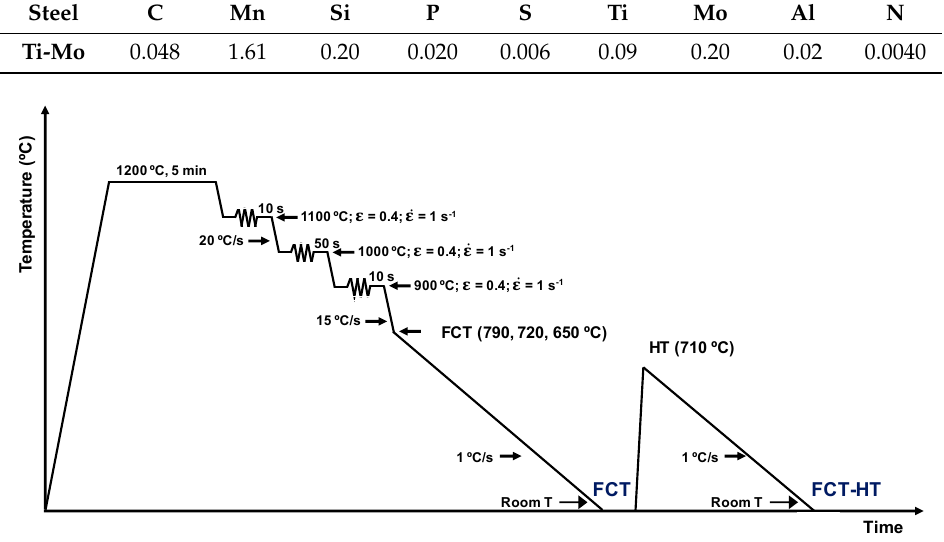
Figure 1. Schematic of the thermomechanical schedule performed in the plane strain compression machine.